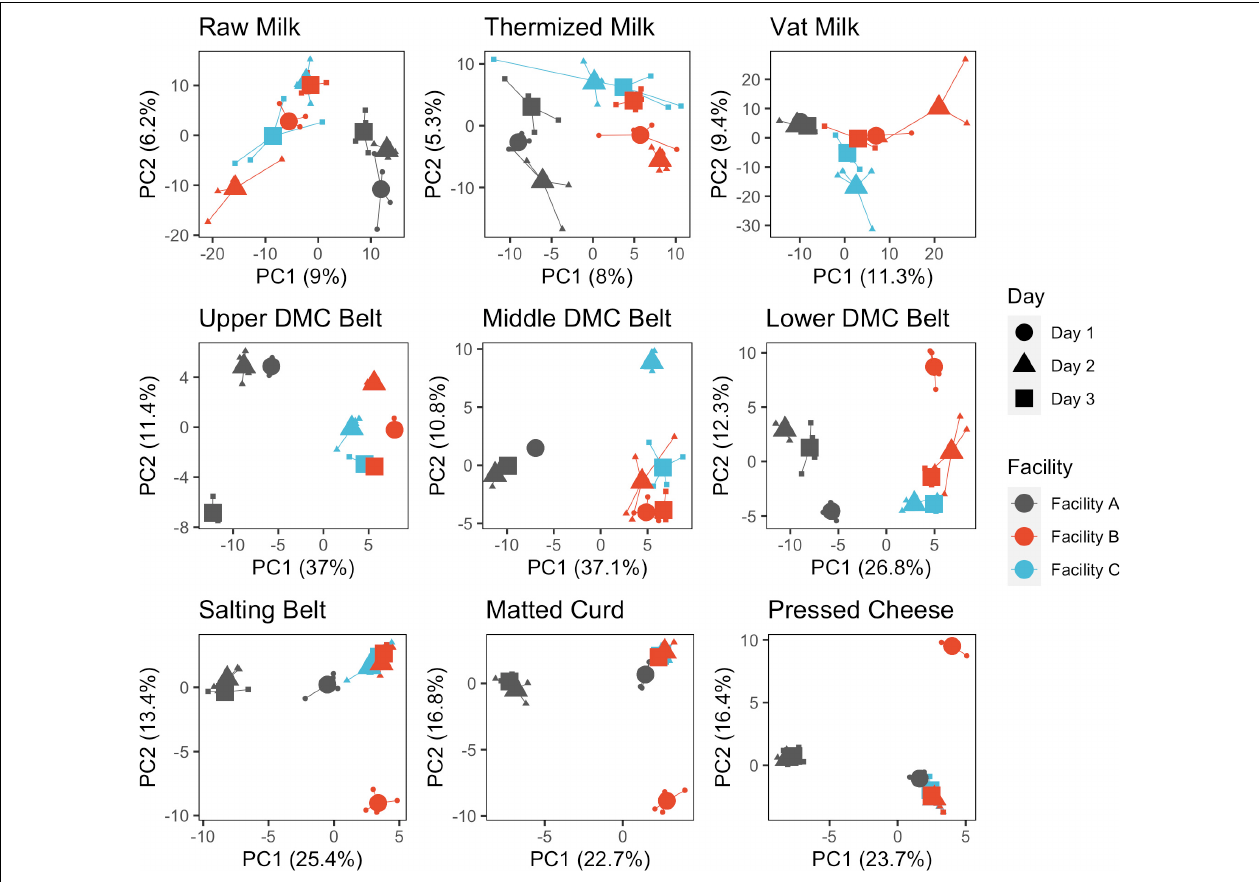
FIGURE 4 | Principle component analysis of microbial communities following clr transformation and separated by sample location. Points are colored by facility and shaped by production day. Samples are grouped by production day nested within facility. Individual samples (small points) are connected by segments to their corresponding group centroids (large points).